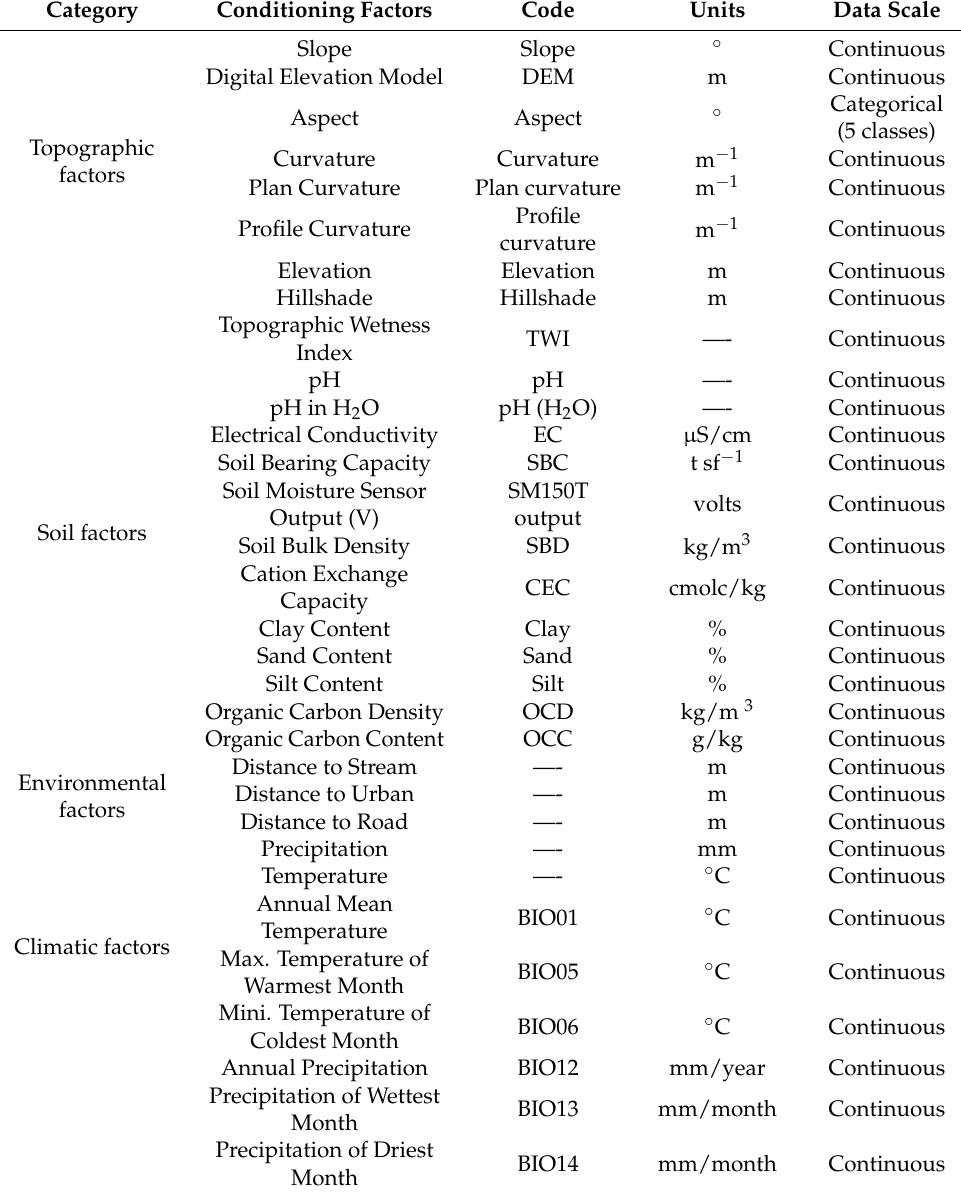
Table 5. Conditioning factors used for prediction of habitat suitability map of C. cordatum